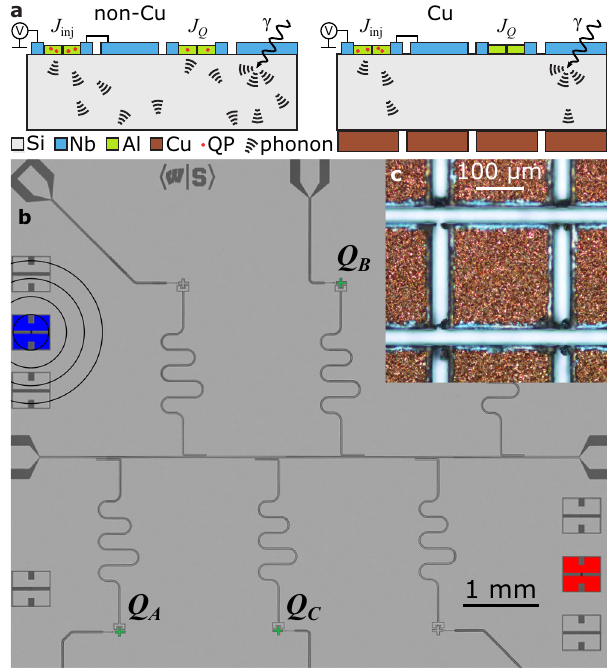
Fig. 1 | Phonon-mediatedQPpoisoning and device layout. a Schematic showing QP/phononinjection, γ impact,phononpropagationinsubstrate,andpairbreaking inqubitjunctionswithandwithoutCu. b Opticalmicrographofdevicelayer.Qubits ( Q A , B , C )arecoloredgreen.JunctionsusedtoinjectQPsintotheCu(non-Cu)chipare highlighted in blue (red); concentric rings represent propagating phonons. c Optical micrograph of Cu islands on back side of Cu